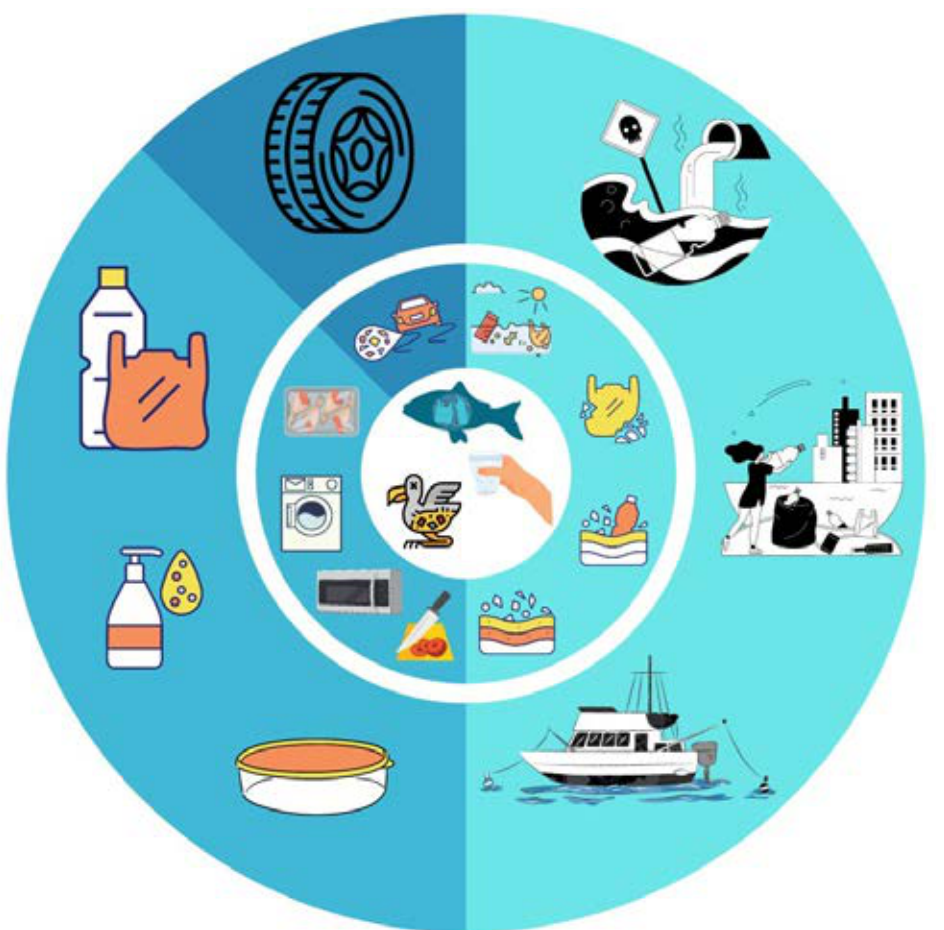
Figure 1. Scheme of food contamination due to MPs.